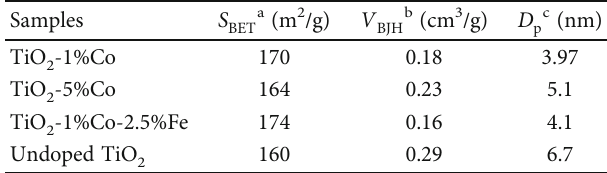
Figure 5: Pore size distributions of representative samples: (a) TiO Table 2: Surface characteristics of the representative TiO